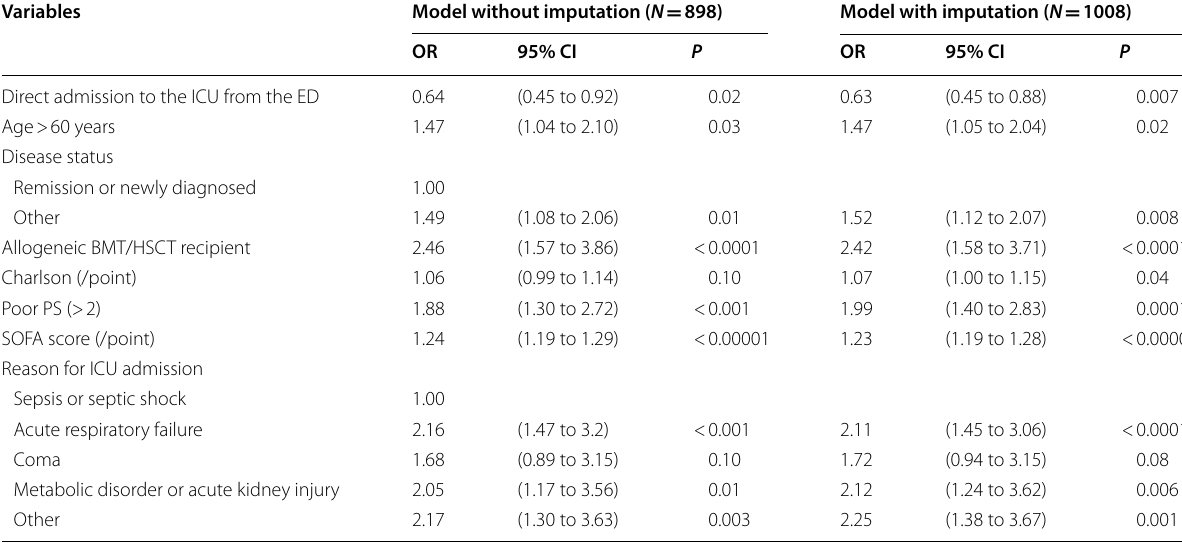
BMT bone marrow transplantation, ED emergency department, HSCT hematopoietic stem-cell transplantation, ICU intensive care unit, PS performance status, SOFA Sequential-Related Organ Failure Assessment